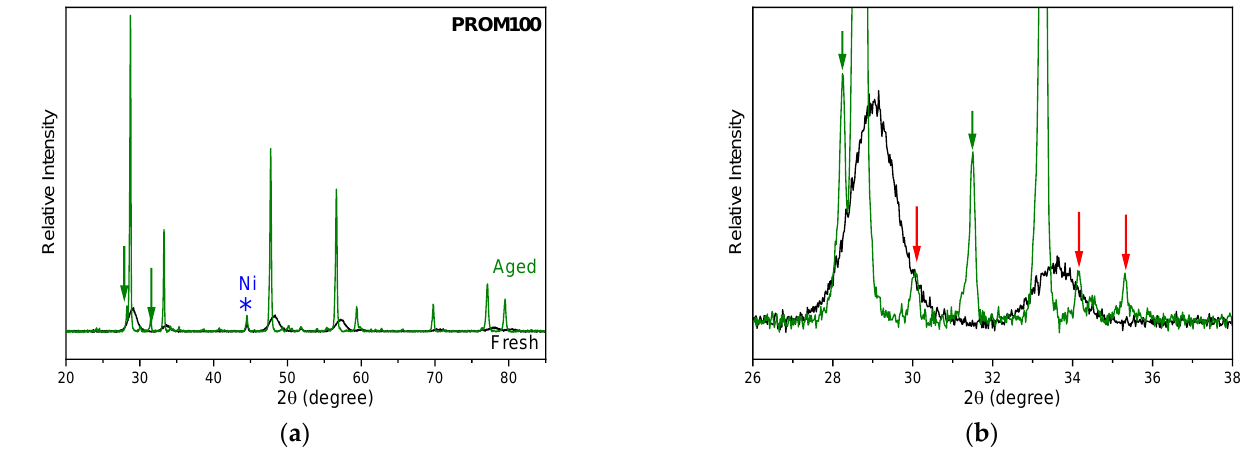
Figure 5. ( a ) XRD diffractograms for PROM100-fresh and PROM100-aged samples; ( b ) focus on the low-intensity peaks observed. The refractive peak indicated with asterisk correspond to Ni, which was added to samples for calibration purposes.